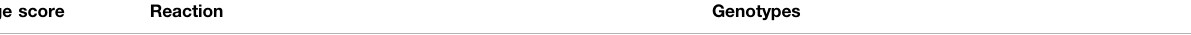
TABLE 5 | Grouping of genotypes based on the reaction to BPH damage. Damage score